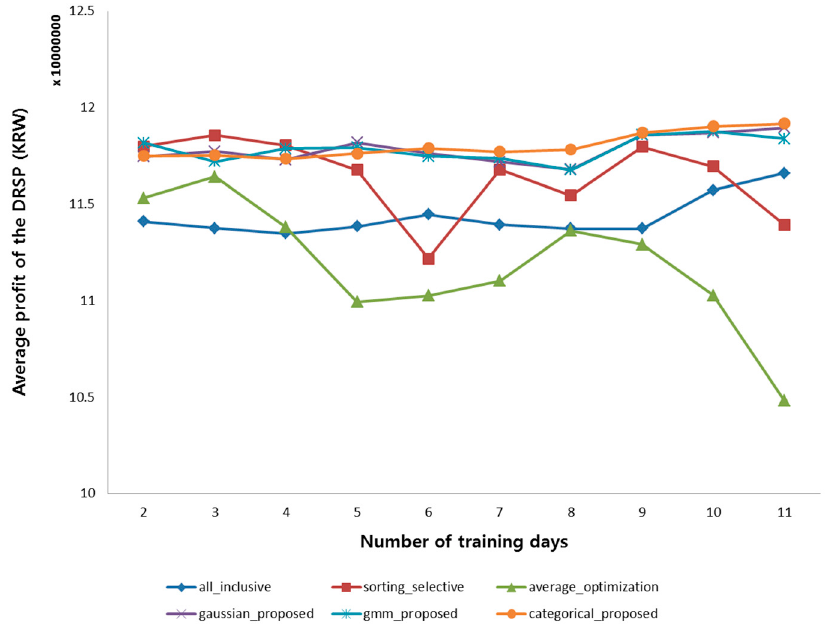
Figure 8. Profit comparison of the proposed optimization. The real average profit of the proposed method is larger than those of all the other baselines.